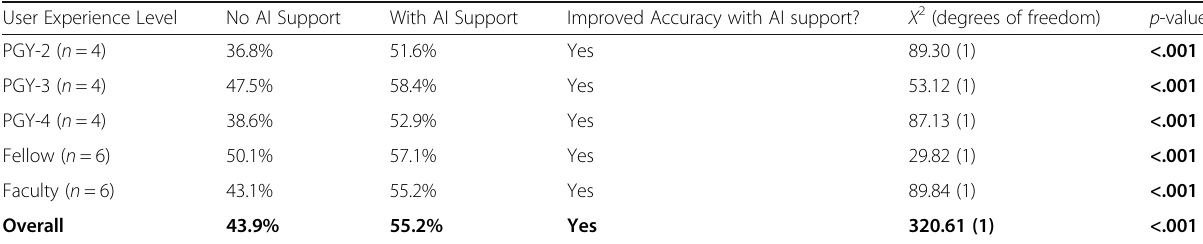
Table 2 Accuracy by experience